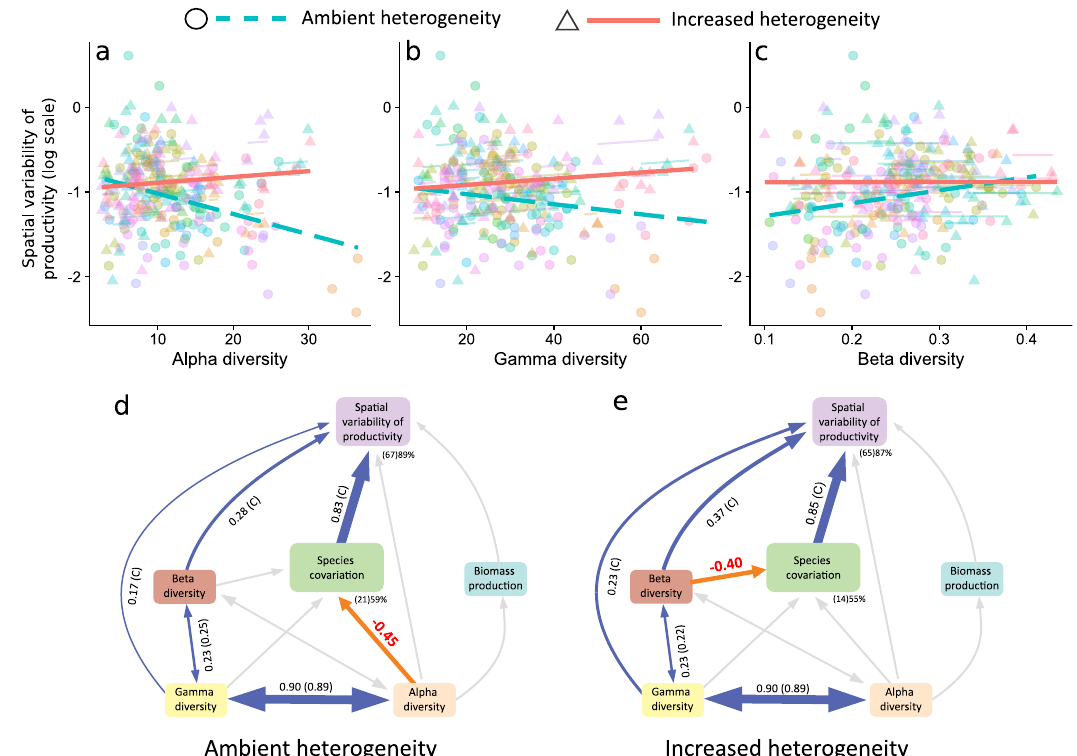
Fig.4 |Experimentallyincreasedheterogeneityweakenedthediversity-spatial variability relationships. a Alpha-diversity (diversity*heterogeneity interaction slopes and 95% con fi dence intervals: 0.0046 (0.0077 to 0.0108)). b Gamma- diversity(0.0029(0.0015to0.0043)). c Beta-diversity( − 0.309( − 0.617to − 0.002)). Different colors represent different sites (see Fig. 2 for site color key assignment), majorlinesrepresentthe fi xed-effectlinearregressionslopesamongsitesandsmall colored lines show patterns within sites. Comparison of SEM models with d ambientand e experimentallyincreasedspatialheterogeneity,usingthesubsetof 42sitesthatimplementedtheexperimentalprotocol,identi fi edtwomajorchanges (rednumbers; P ≤ 0.05inmultigroupanalysis;seeSupplementaryTable7forexact P values) in the pathways whereby increased heterogeneity weakened the three diversity – variability relationships: (1) the negative relationship between alpha- diversity and species covariation under ambient conditions was neutral under increased spatialheterogeneity;(2)the neutralrelationship betweenbeta-diversity and species covariation under ambient conditions became negative under increasedheterogeneity.Model fi twasassessedusingShipley ’ stestofd-separation (ambient heterogeneity: Fisher ’ s C =1.108, df=6, P =0.981; experimentally increased spatial heterogeneity: Fisher ’ s C =3.108, df=4, P =0.54). Solid blue